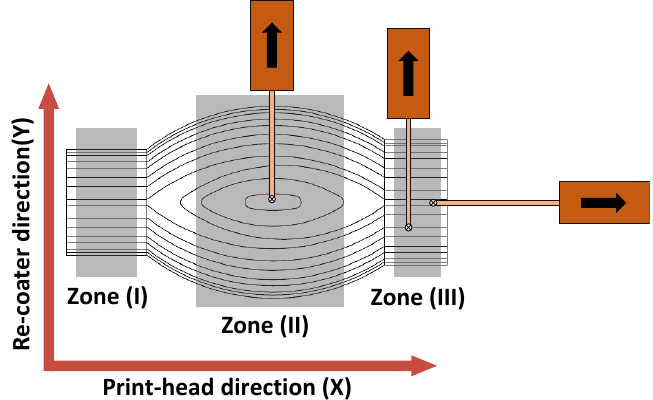
Figure 6. Zones and directions for measuring the roughness of castings.